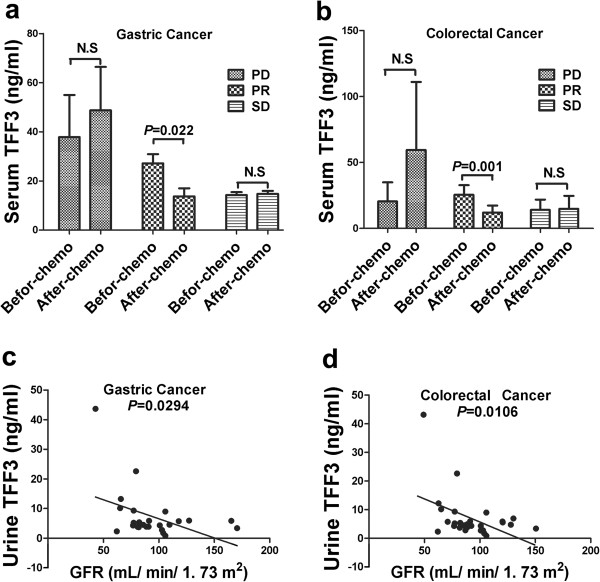
Serum TFF3 analysis in the chemotherapy group and correlation analysis between urine TFF3 and the GFR. (a) and (b) present an analysis of serum TFF3 levels in the PR, SD and PD groups of patients with gastric and colorectal cancer before and after chemotherapy, respectively. The significant ratios with P < 0.05 between 2 groups (before and after chemotherapy in the PR group of gastric and colorectal cancer). (c) and (d) present a correlation analysis between urine TFF3 levels and the GFR in patients with gastric and colorectal cancer, respectively. Urine TFF3 levels were significantly negatively correlated with the GFR in both the gastric and the colorectal cancer groups (P < 0.05).